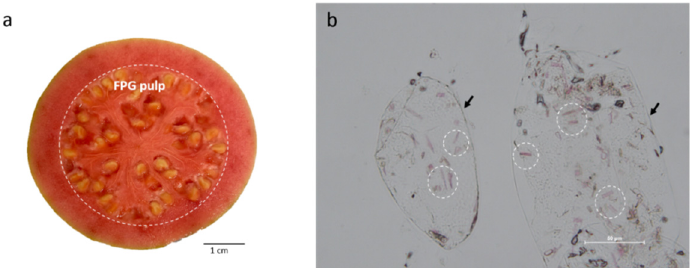
Figure 1. Guava ( Psidium guajava L.) sections. ( a ) Photograph of the transversal section of a recently cut PFG. Pulp is enclosed in a dashed circle; ( b ) micrograph of FPG pulp 20×. Inside the dashed circles are lycopene crystals; the black arrows point to the plant cell wall.